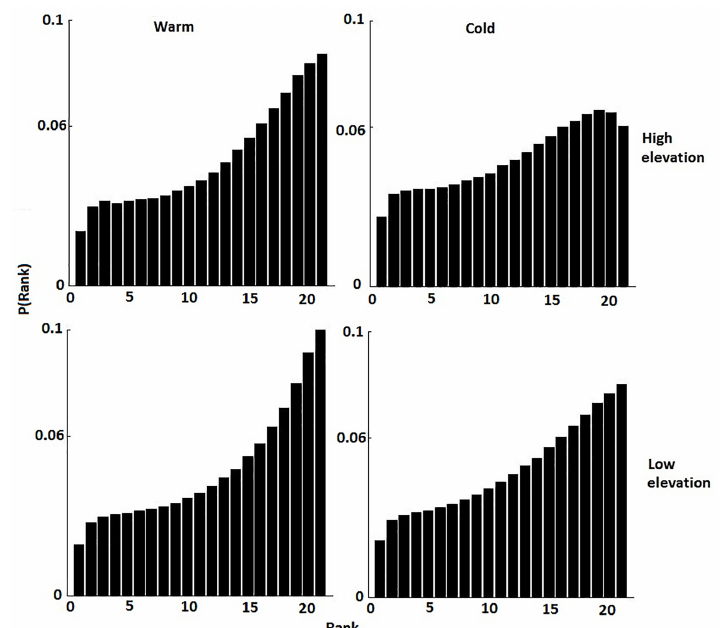
Figure 9. Rank histogram for warm and cold